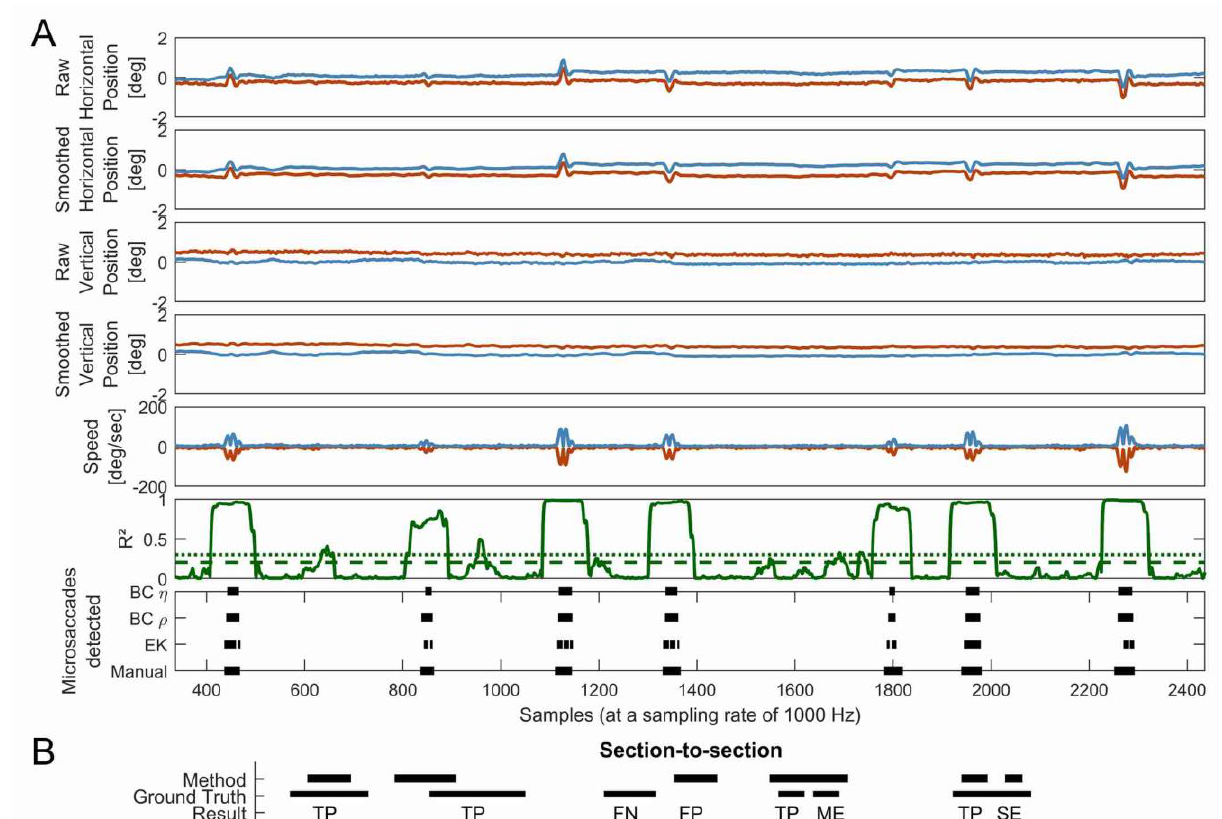
Figure 4: A: Comparison of microsaccade detection methods and their mapping onto smoothed gaze data, speed and correlation pro- files for P4. The red lines indicate data from the left eye and the blue lines indicate data from the right. The green solid line represents the moving correlation of the speeds between both eyes with a window size of 65 ms. The corresponding finely dashed green line represents a η value of 7 and the coarsely dashed green line indicates a ρ value of .45. A total of just over 2000 samples or 2 seconds is shown. Note: Speed in the left eye is represented as negative to facilitate readability of the graph. B: Graphical explanation of how the ground truth and detection method were compared. TP: true positive; FN: false negative; FP: false positive; ME: merged event; SE: split event. Further explanation is given in the